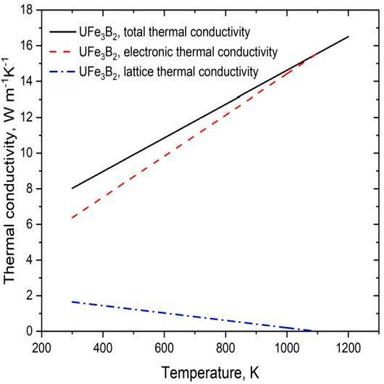
Total, electronic, and lattice thermal conductivity of annealed UFe3B2 sample.